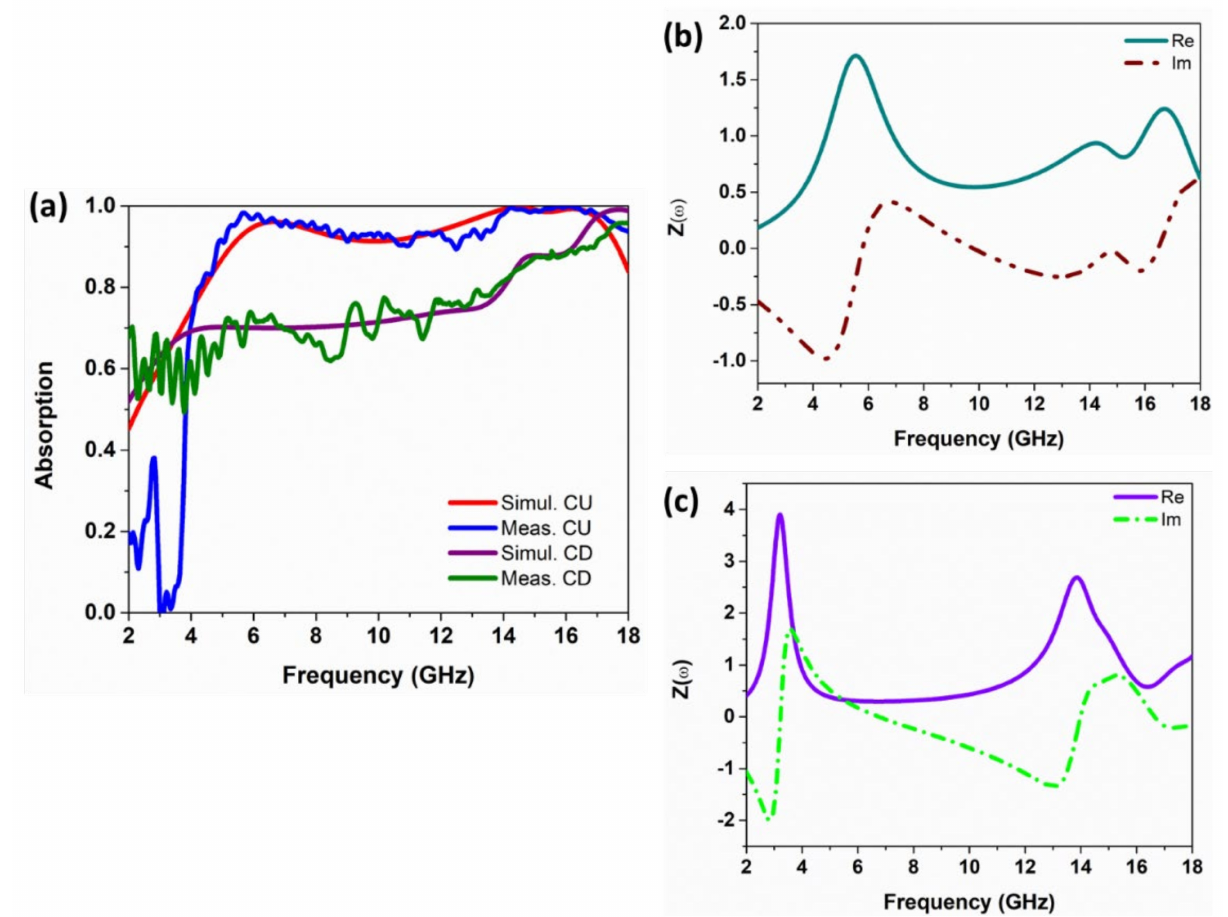
Figure 2. Comparison between simulated and measured absorption spectra in the case of ( a ) CU and CD states. Extracted effective impedances of the proposed structure for the ( b ) CU and ( c ) CD cases. To understand the mechanism of recoverable broadband-absorption properties, the distributions of induced surface currents on the graphene-ink and metallic layers were simulated at resonant frequencies of 6.6, 14.5, and 16.2 GHz, as plotted in Figure 3. It can be observed that, in Figure 3a, the top and bottom surface currents at a frequency of 6.6 GHz are anti-parallel. This phenomenon confirms the fundamental magnetic resonance as the common effect